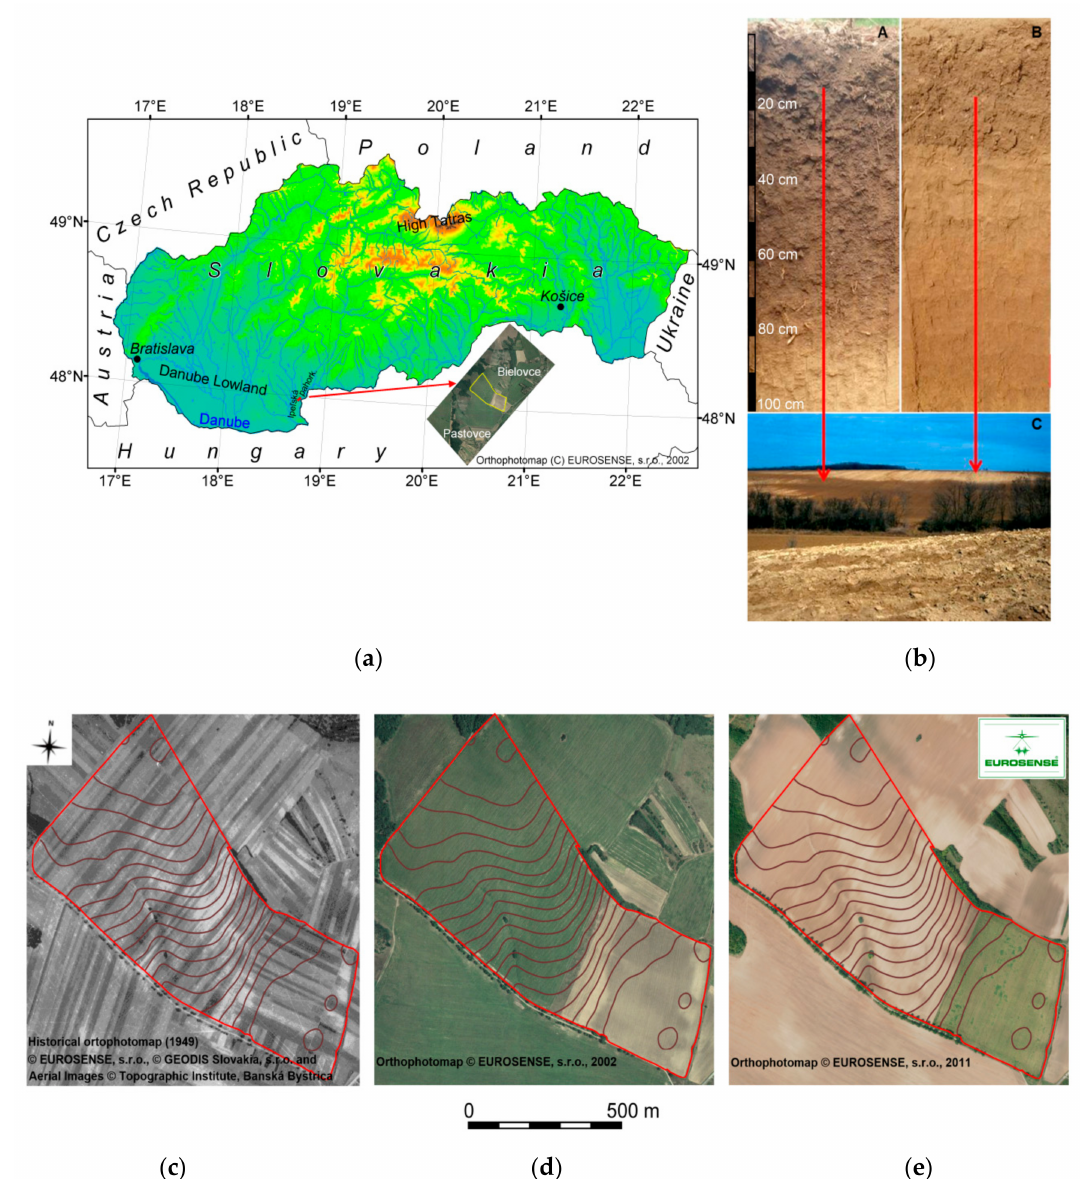
Figure 1. Study site: ( a ) location; ( b ) soil cover (original Chernozem (A), eroded Calcisol (B) and bright eroded patterns (C)); land-use structure in 1949 ( c ), 2002 ( d ) and 2011 ( e ) with 5 m contour